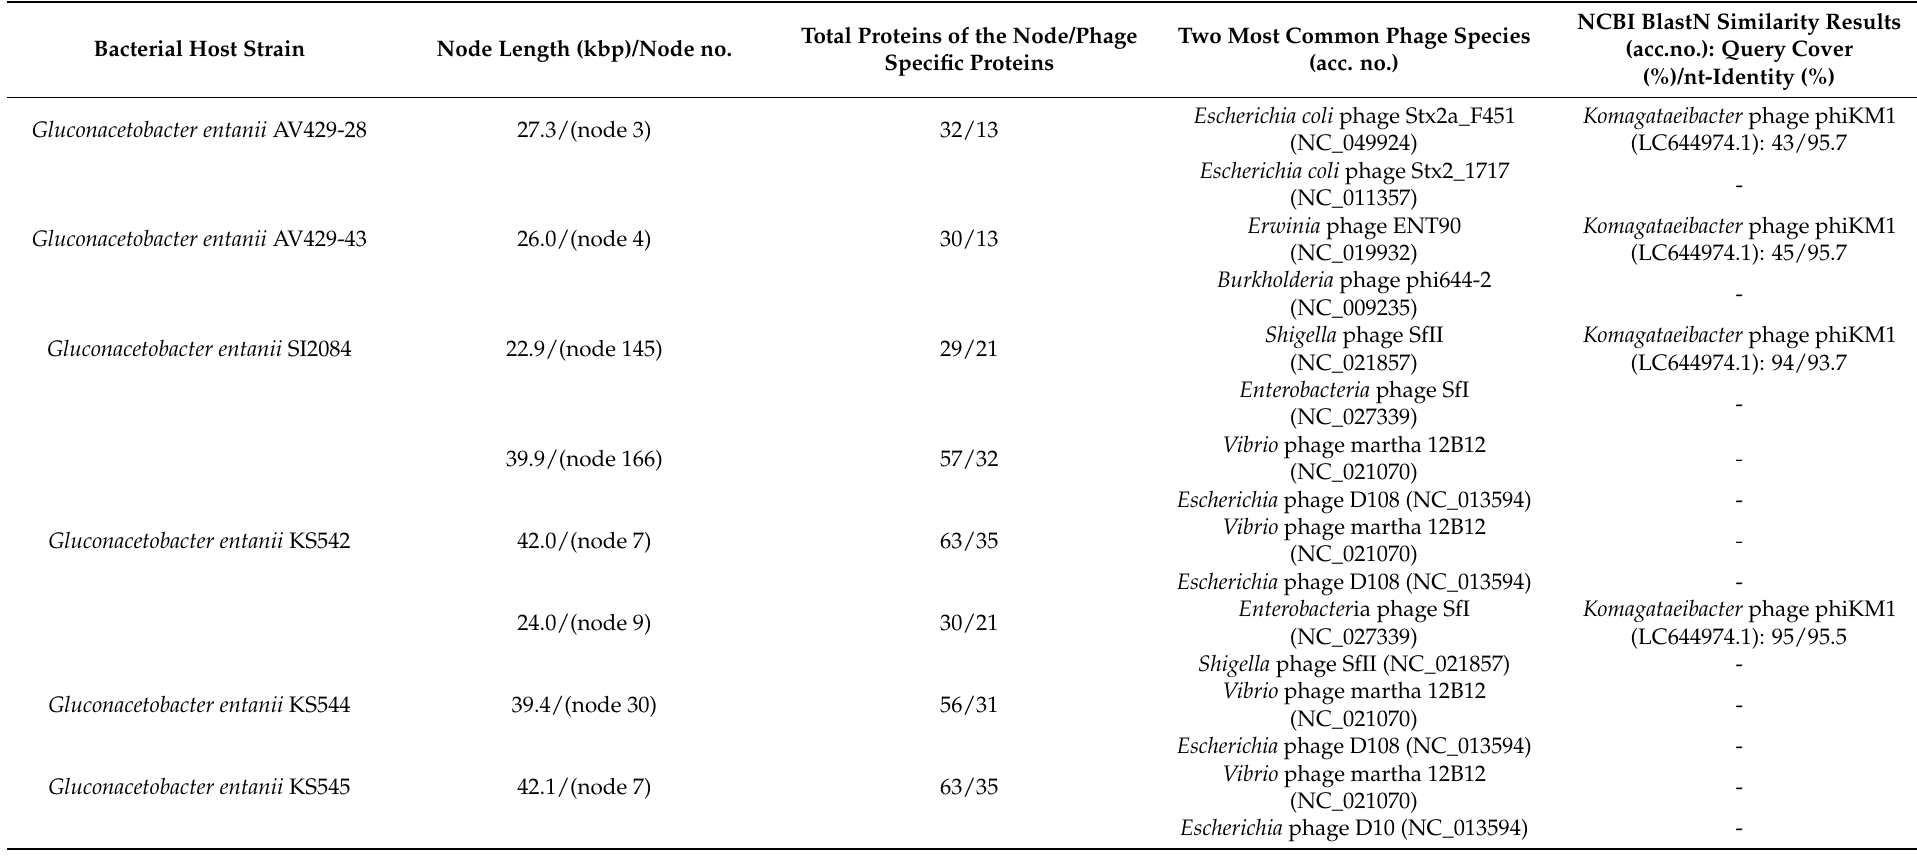
Table 7. Prophage identification in Gluconacetobacter entanii genomes using web-based tool Phaster. Bacterial Host Strain Node Length (kbp)/Node no.